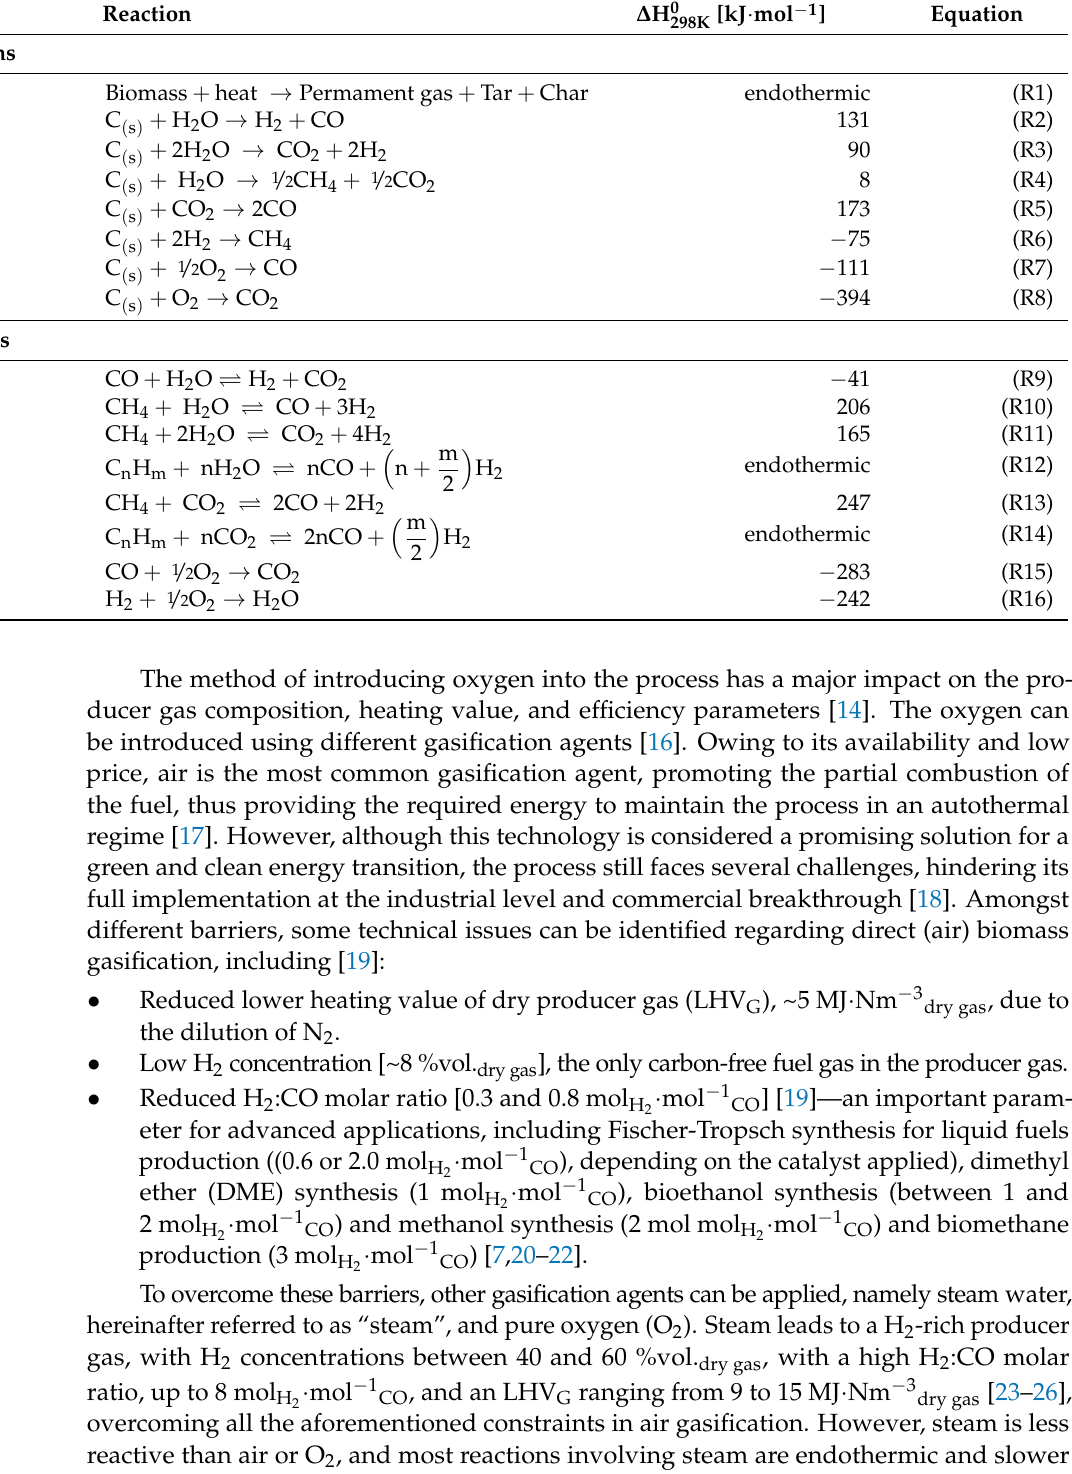
Table 1. Main biomass gasification reactions [10,14,15].